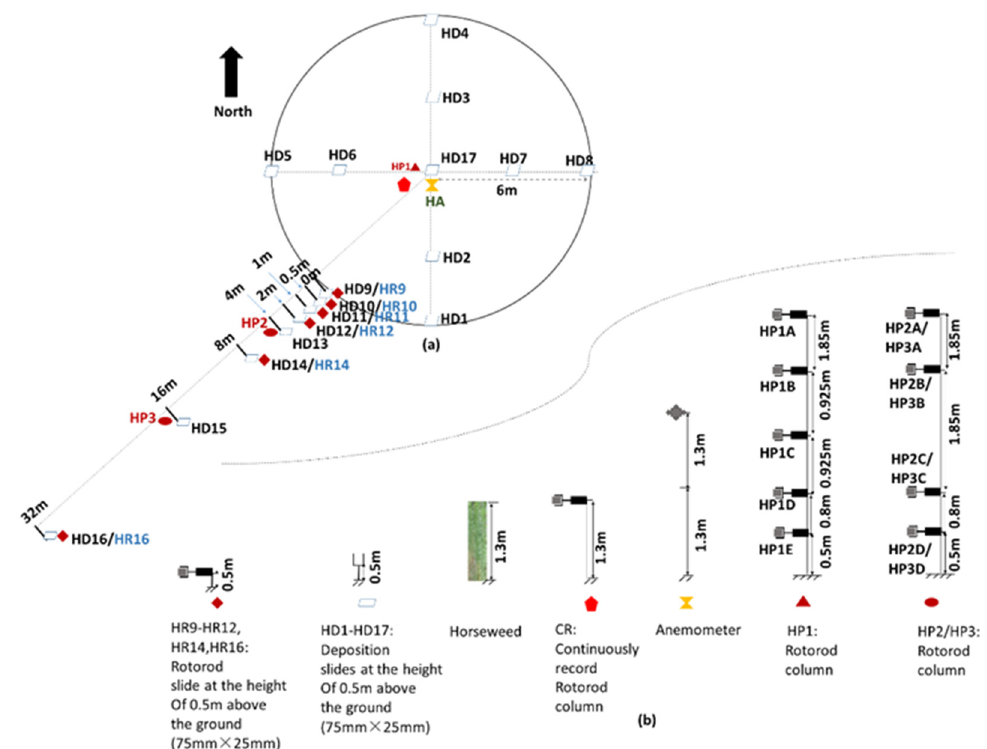
Figure 12. Schematic map and setup of the experiment at the Tennessee field: ( a ) Experimental site; ( b ) Sampler heights. The concentration (grains/m 3 ) was measured by three Rotorod columns (HPi, i = 1 to 3) and Rotorod slides at the height of 0.5 m above the ground (HRi, i = 1 to 12,14,16). HP1 was placed at the center of the field, with five Rotorod samplers (‘HP1i’, i = A to E) positioned at different heights. HP2 and HP3 were placed 4 and 16 m away from the edge of the circular field in the downwind direction, with four Rotorod samplers (‘HPji’, j = 2 to 3, i = A to D). Deposition (grains/m 2 /s) was data collected by slides (75 mm × 25 mm) in and outside of the field at the height of 0.5 m above the ground. In the field, two sampling lines (containing a total of nine sampling locations: HD1 to HD8, HD17) were set up in the direction of east to west and south to north. Outside of the field, there were 8 more deposition slides placed along the downwind direction (HD9 to HD16). An additional sampler (CR) and a sonic anemometer were placed in the field.